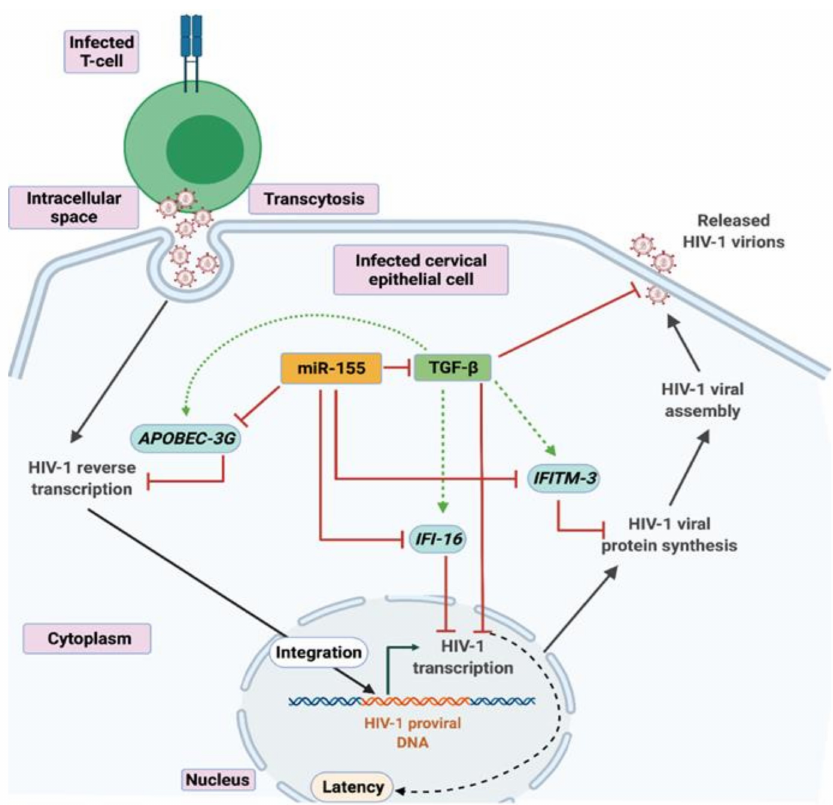
Figure 4. A graphical representation showing the molecular mechanism involved in TGF- β mediated suppression of HIV release in the cervical epithelial cells. HIV-1 infects cervical epithelial cells via cell–cell contact through transcytosis. Reduced TGF- β promotes HIV release in the cervical epithelium which is regulated by miR-155. Inhibition of miR-155 leads to increased TGF- β signaling and host restriction factors— APOBEC-3G, IFI-16 and IFITM-3, resulting in decreased HIV release in the cervical cells. This image is created using BioRender.